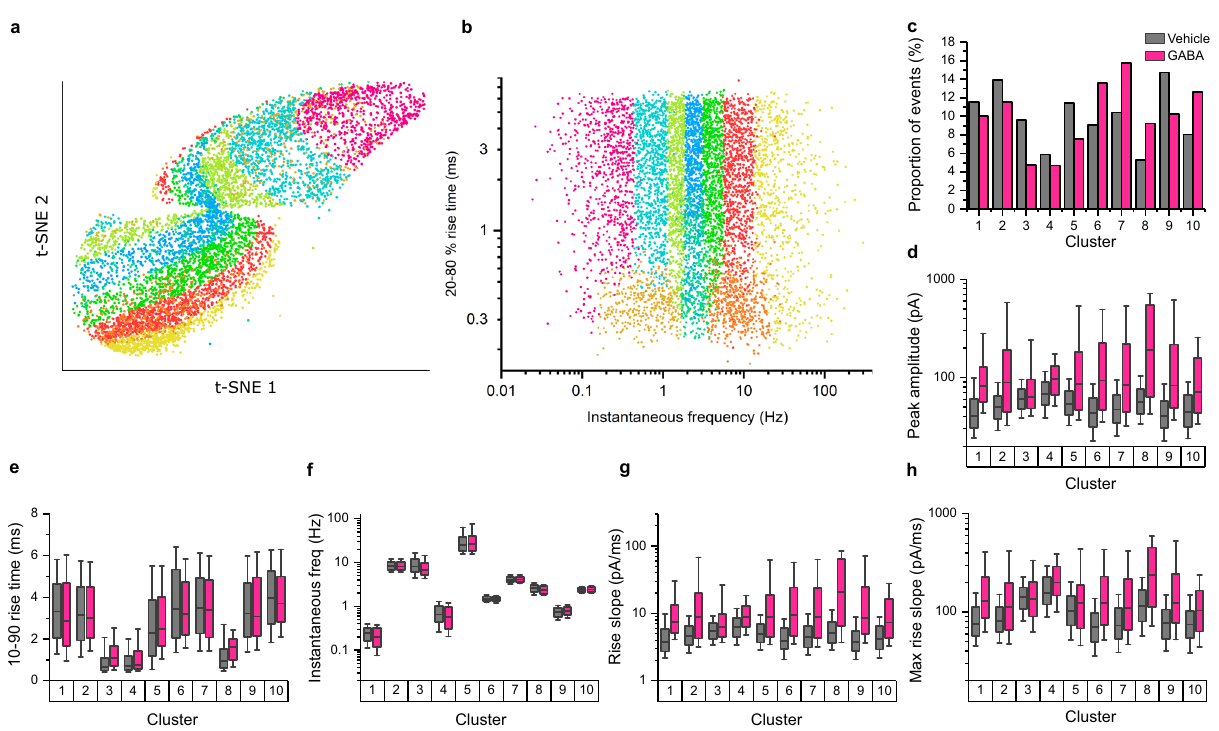
Fig. 6 Cluster analysis of sIPSCs. a T-distributed stochastic neighbour embedding (t-SNE) plot of all mock or GABA-pretreated sIPSCs from Fig. 5. The t-SNE plot was produced using the same parameters used to analyse the clustering of events (see ‘ Methods ’ ). Events are colour coded according to the clustering determined by skewed mixture modelling of the data (10 total clusters). b Plot of 20 – 80% rise time against instantaneous frequency of all sIPSCs, coloured by cluster. c Proportion of vehicle (grey) and 1 mM GABA-pretreated (pink) IPSC events in each cluster identi fi ed by the skewed mixture modelling. d – h Comparison of vehicle against GABA-treated events for each of the 10 clusters, for d peak IPSC amplitude, e 10 – 90% rise time, f instantaneous frequency, g rise slope and h maximum rise slope. On all boxplots, the box represents the interquartile range, the line within the box represents the median, and the whiskers represent the 10 – 90% range. Source data are provided as a Source data fi le for Fig.